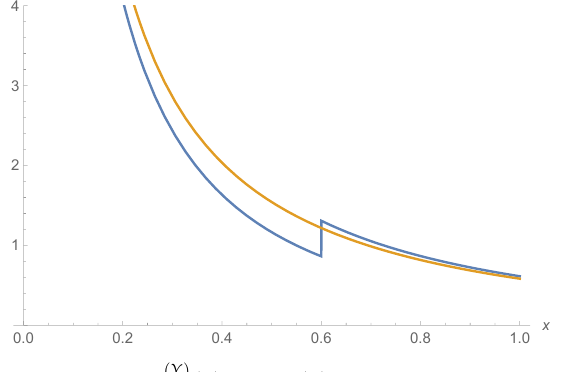
( Y ) ( x ) and r ( x ) (from bottom to top near the origin) for the Y u , t